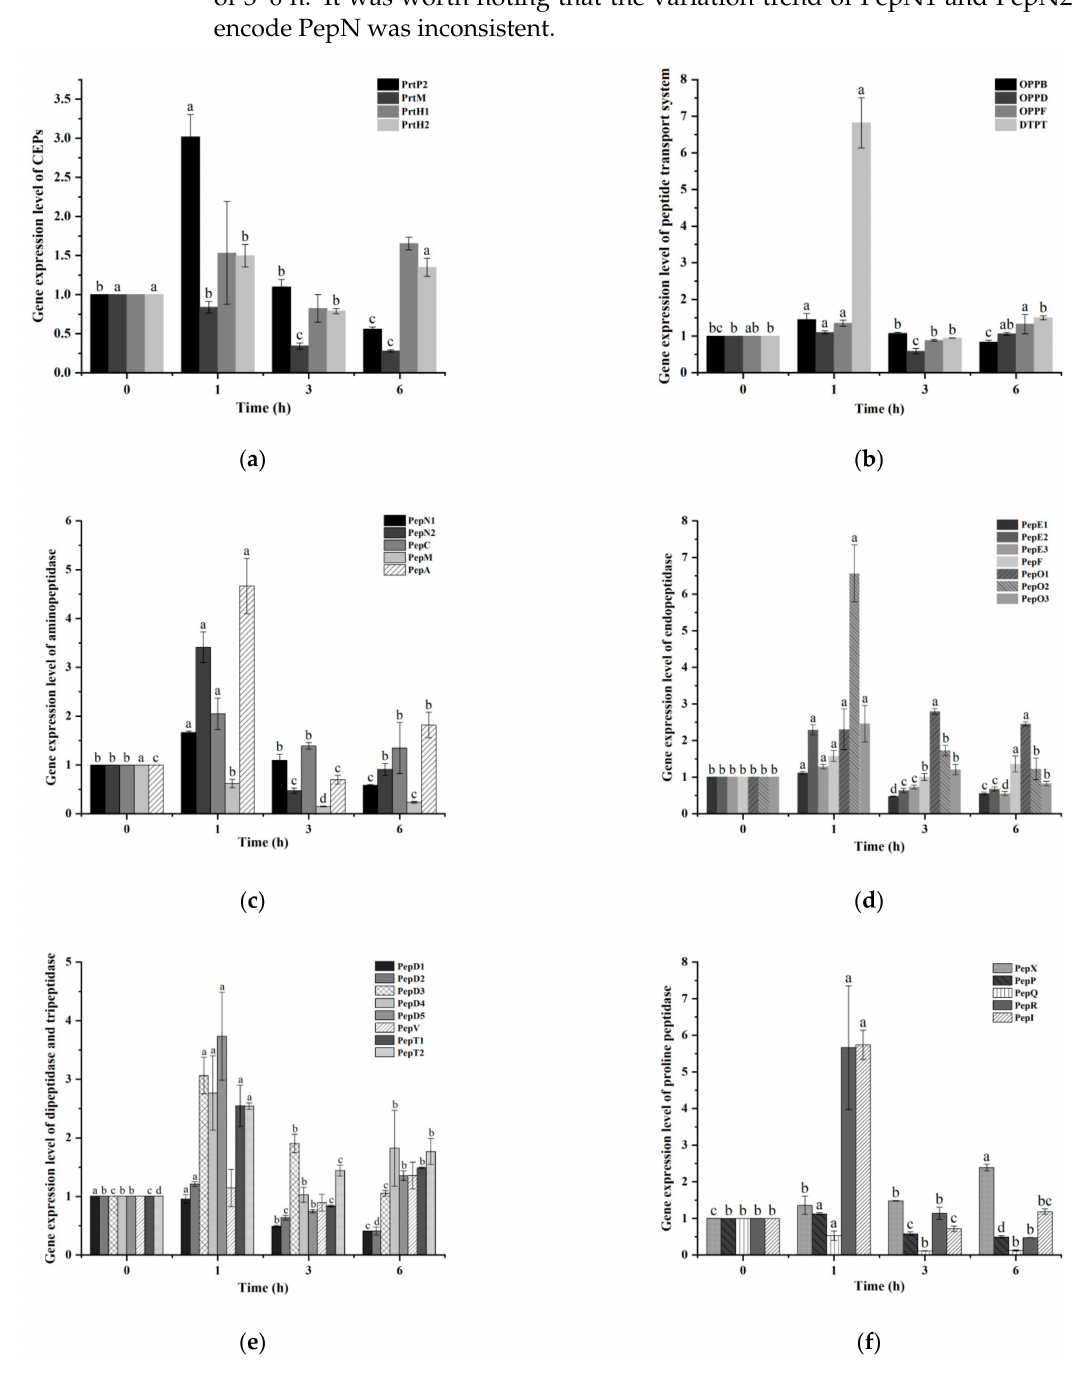
Figure 2. Gene expression of different enzymes. ( a ) represents the expression level of CEP-related genes, ( b ) reveals the level of gene expression of the peptide transport system, ( c ) describes the gene expression level of aminopeptidase, ( d ) is the gene expression level of endopeptidase, ( e ) shows the gene expression level of dipeptidase and tripeptidase, ( f ) explains the gene expression level of the related proline peptidase. Different letters indicate significant differences ( p -value of ≤ 0.05) within each subsection of the